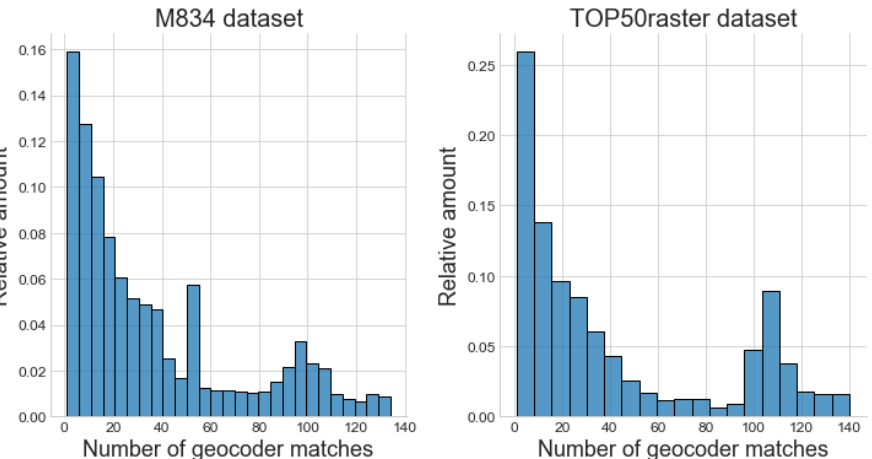
Figure 5. Histograms show the distribution of the number of geocoder matches per recognized text label for both datasets. Many text labels have a large number of geocoder matches (>50), which do not provide much